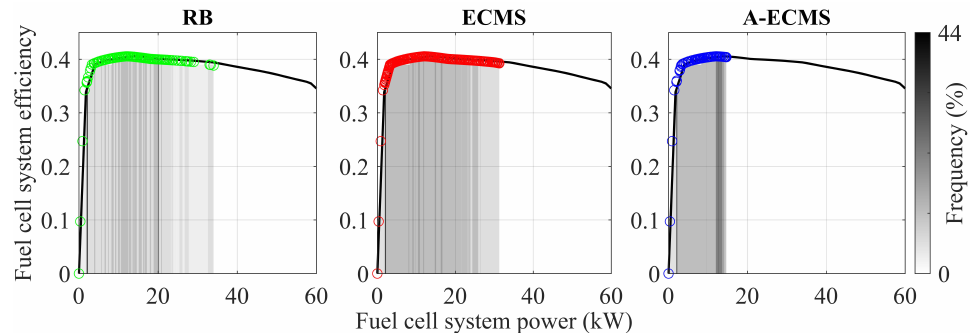
Figure 13. Operating points of the fuel cell system using different